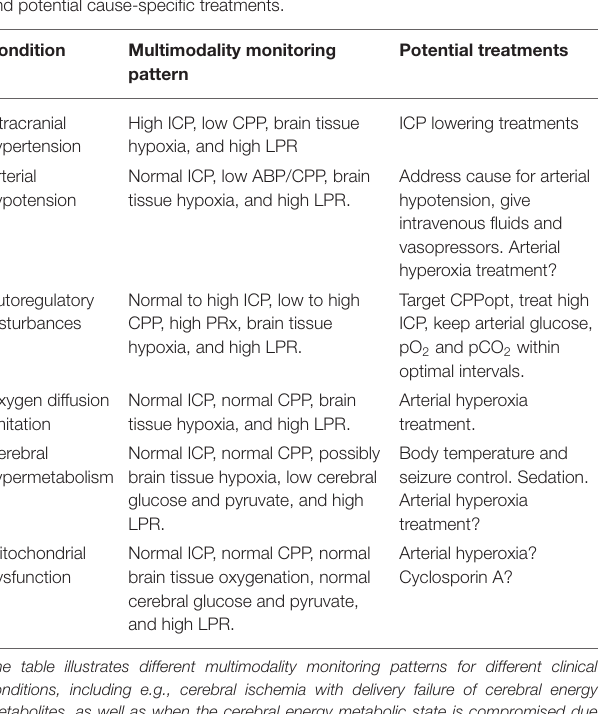
Frontiers in Neurology |